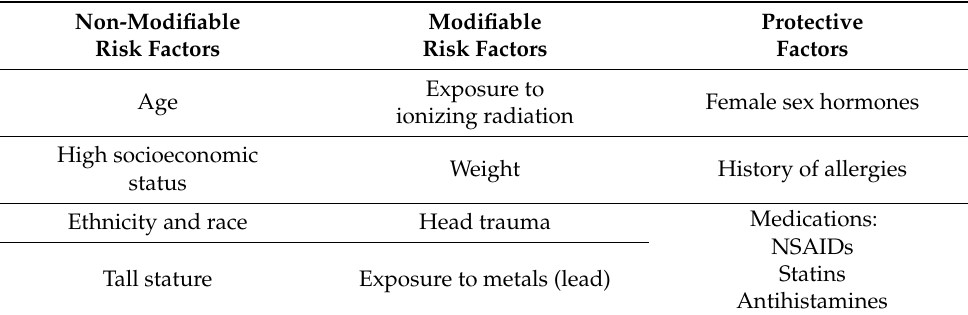
Table 2. Risk and protective factors for